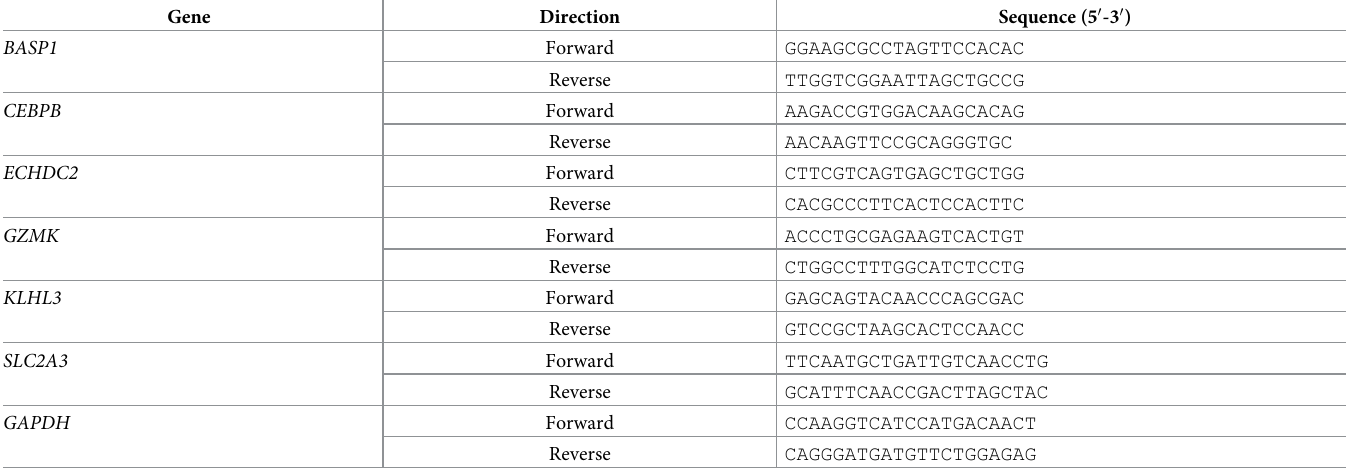
Table 2. Sequences of the qRT-PCR primers used in this